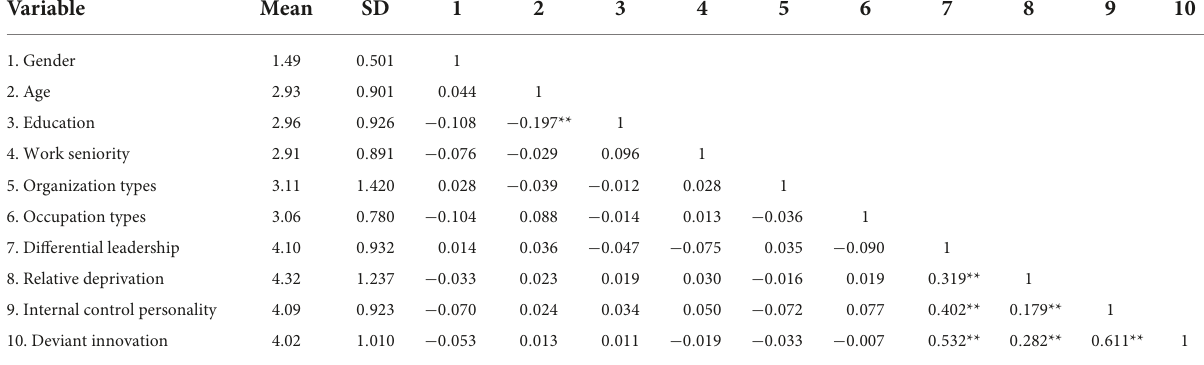
TABLE 2 Descriptive statistical results for the variables.